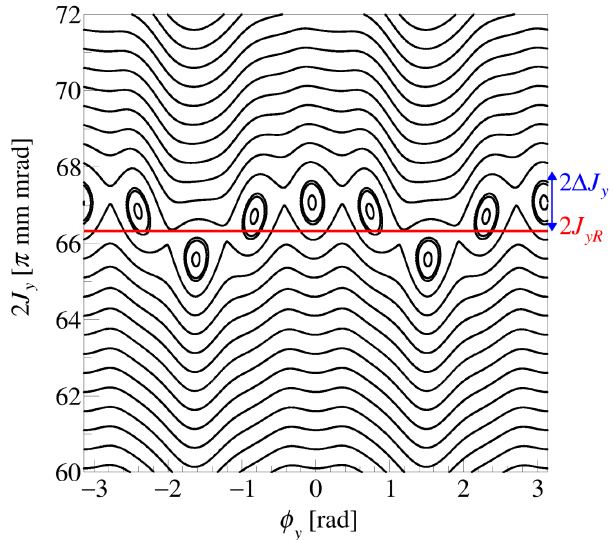
FIG. 9. Simulated Poincar´e map in the vertical plane with the new optics. The horizontal action was set to J x ¼ 0 . The red line represents the analytical solution of the vertical action of the on- resonance particles 2 J yR